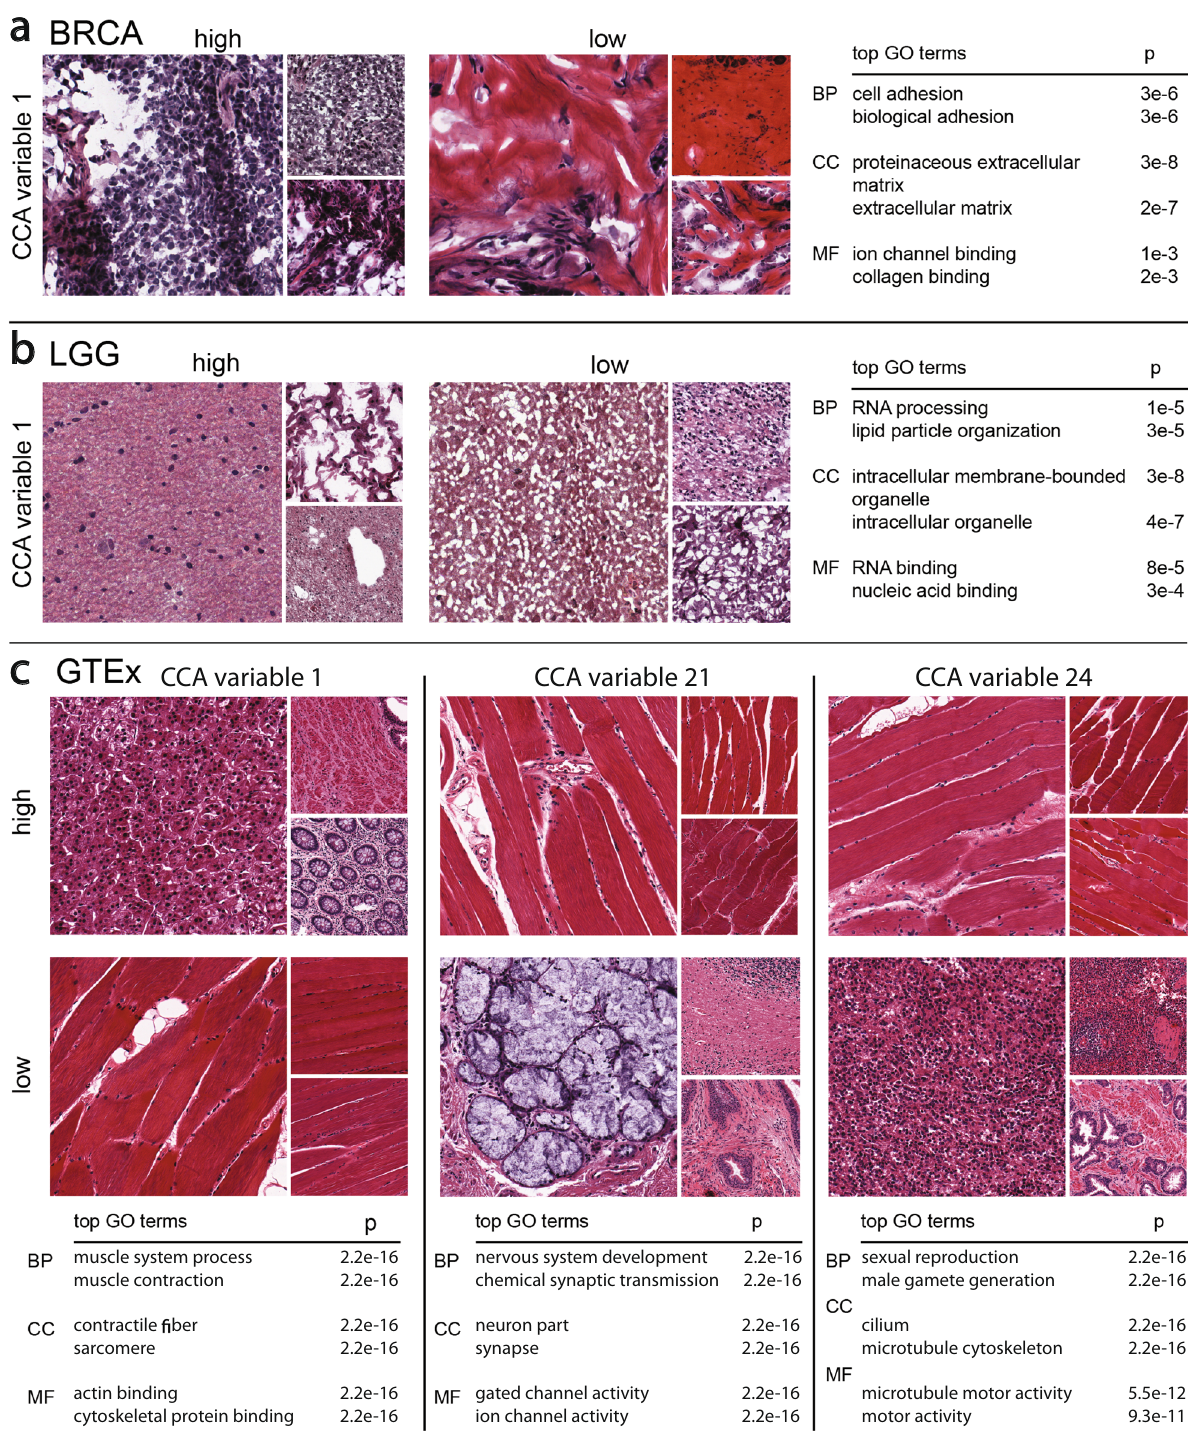
Fig. 2 Results using ImageCCA for three different data sets. We report images sampled from those with the most extreme magnitude positive and negative (10% and 90% in a linear ranking) CCA variable values, and top two GO terms that are most enriched with the corresponding genes with extreme loading values in the same component. BP biological process, CC cellular component, MF molecular function. The p -values reported are uncorrected Fisher ’ s exact tests. Panel a : the fi rst component of the BRCA ImageCCA results; Panel b : the fi rst component of the LGG ImageCCA results; Panel c : three components of the GTEx ImageCCA uncorrected Fisher ’ s exact tests. Looking at the histological involved in cell adhesion ( p ≤ 3 × 10 − 5 ) found in the proteinaceous images associated with the most extreme positive and negative extracellular matrix ( p ≤ 3 × 10 − 5 ) with molecular functions values of the component, we see dramatic differences in the related to ion channel binding ( p ≤ 1 × 10 − 3 ) and collagen binding structure of the stained tissues (Fig. 2a). In particular, images with ( p ≤ 2 × 10 − 3 ). The p -values reported for all GO terms are